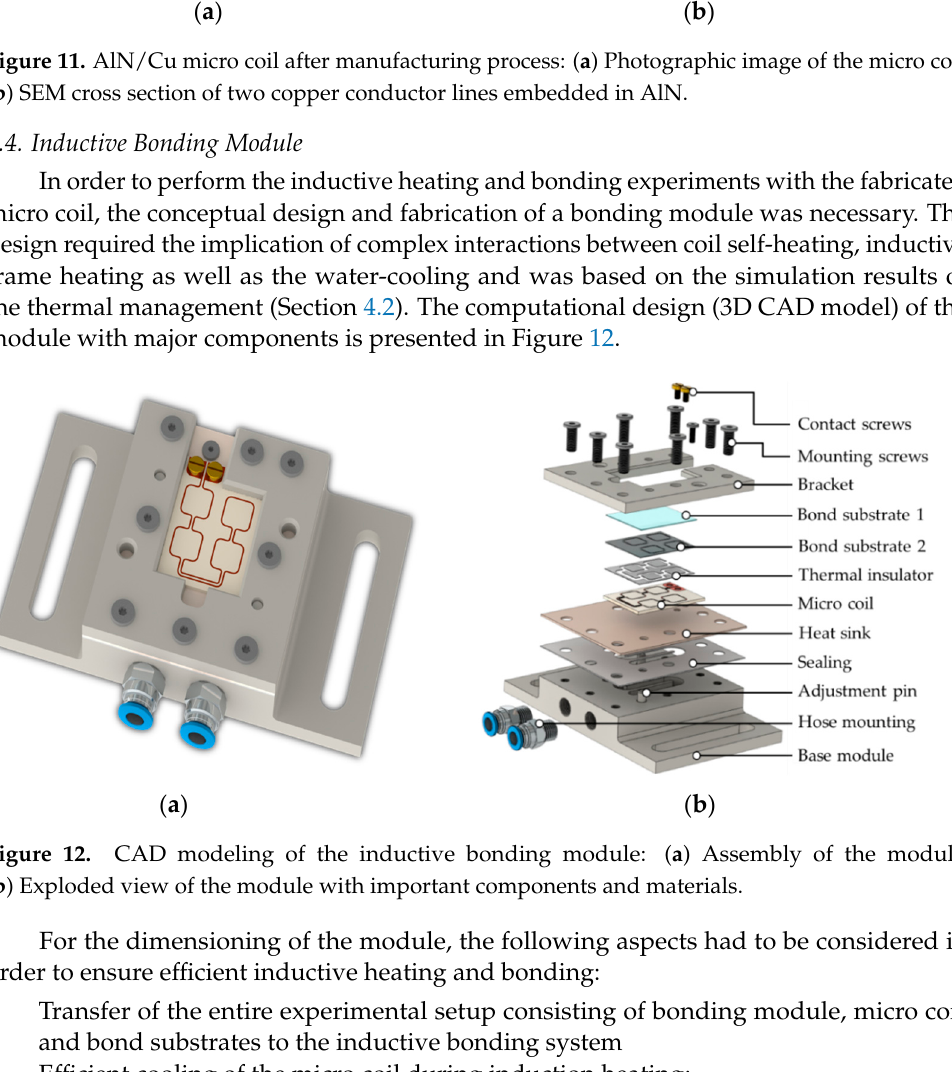
( h ) Figure 13. Assembly of the inductive bond module: ( a ) Individual component; ( b ) Base module with hose mounting; ( c ) Pins for component adjustment; ( d ) Water sealing; ( e ) Heat sink; ( f ) Bracket; ( g ) Screwing with mounting and contact screws; ( h ) Bonding module with Cu/AlN micro coil. In order to ensure maximum flexibility of the bonding process and, if required, to efficiently modify the process setup (e.g., micro coil, heat sink, connection cables), a